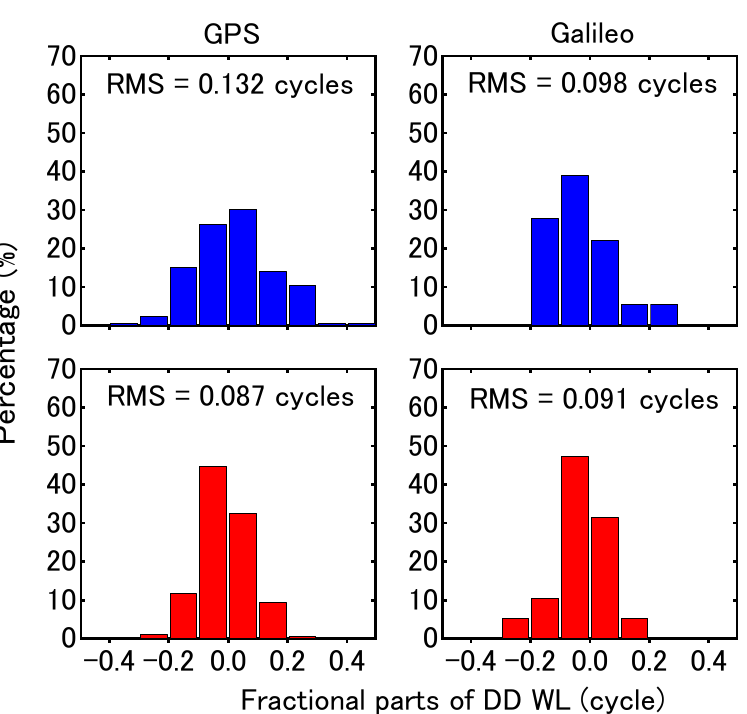
Figure 8. Histogram distribution of the fractional parts of DD WL ambiguities for long baseline MAR6_ZIM2 on DOY 101, 2019, without (top row) and with (bottom row) receiver-related pseu- dorange biases correction.